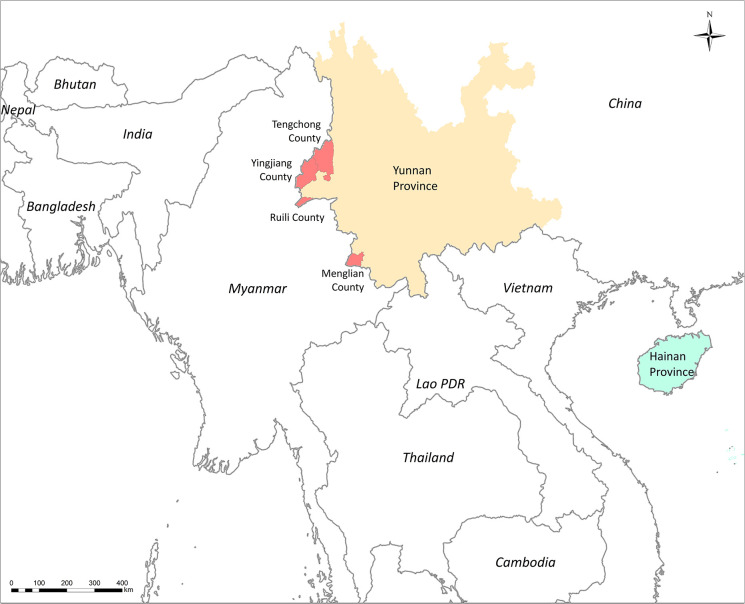
Sites for sample collection in Southern China and countries of samples collection in PCA analysis.